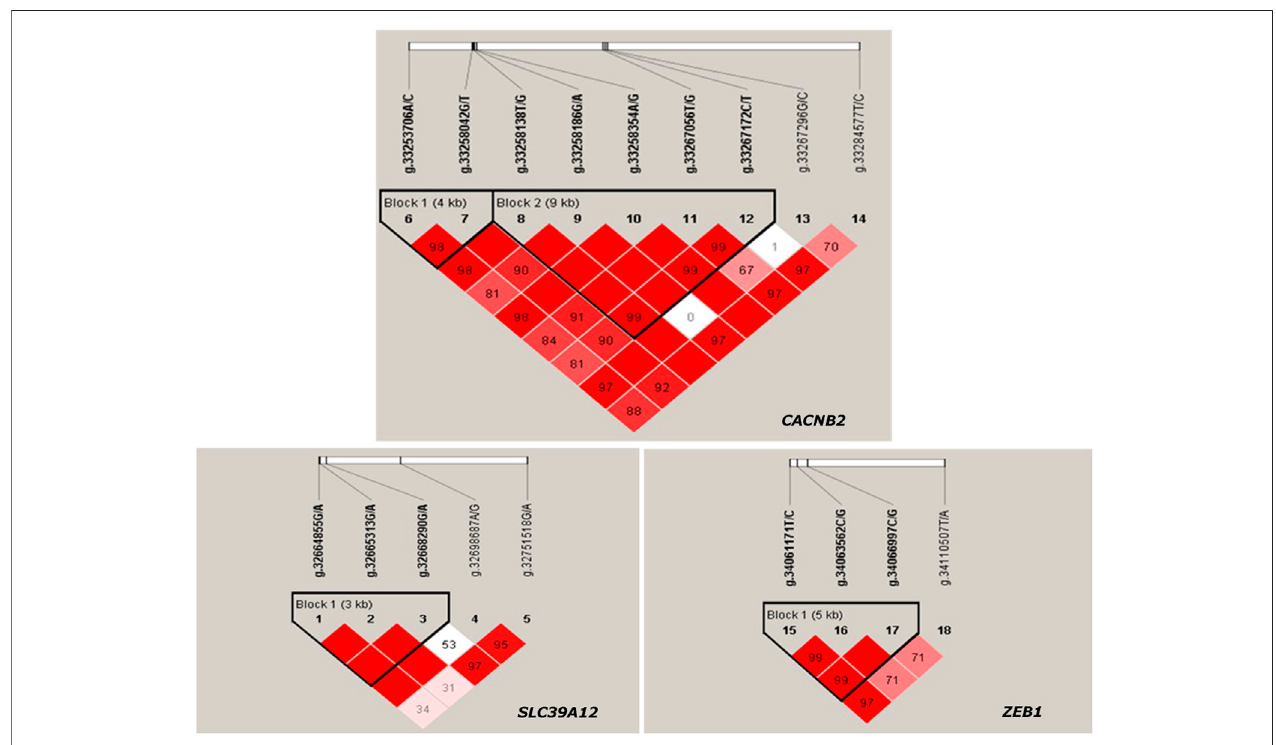
FIGURE 3 | Haplotype blocks constructed based on Linkage disequilibrium (LD) in Chinese Holstein cows for gene CACNB2 , SLC39A12 and ZEB1 .